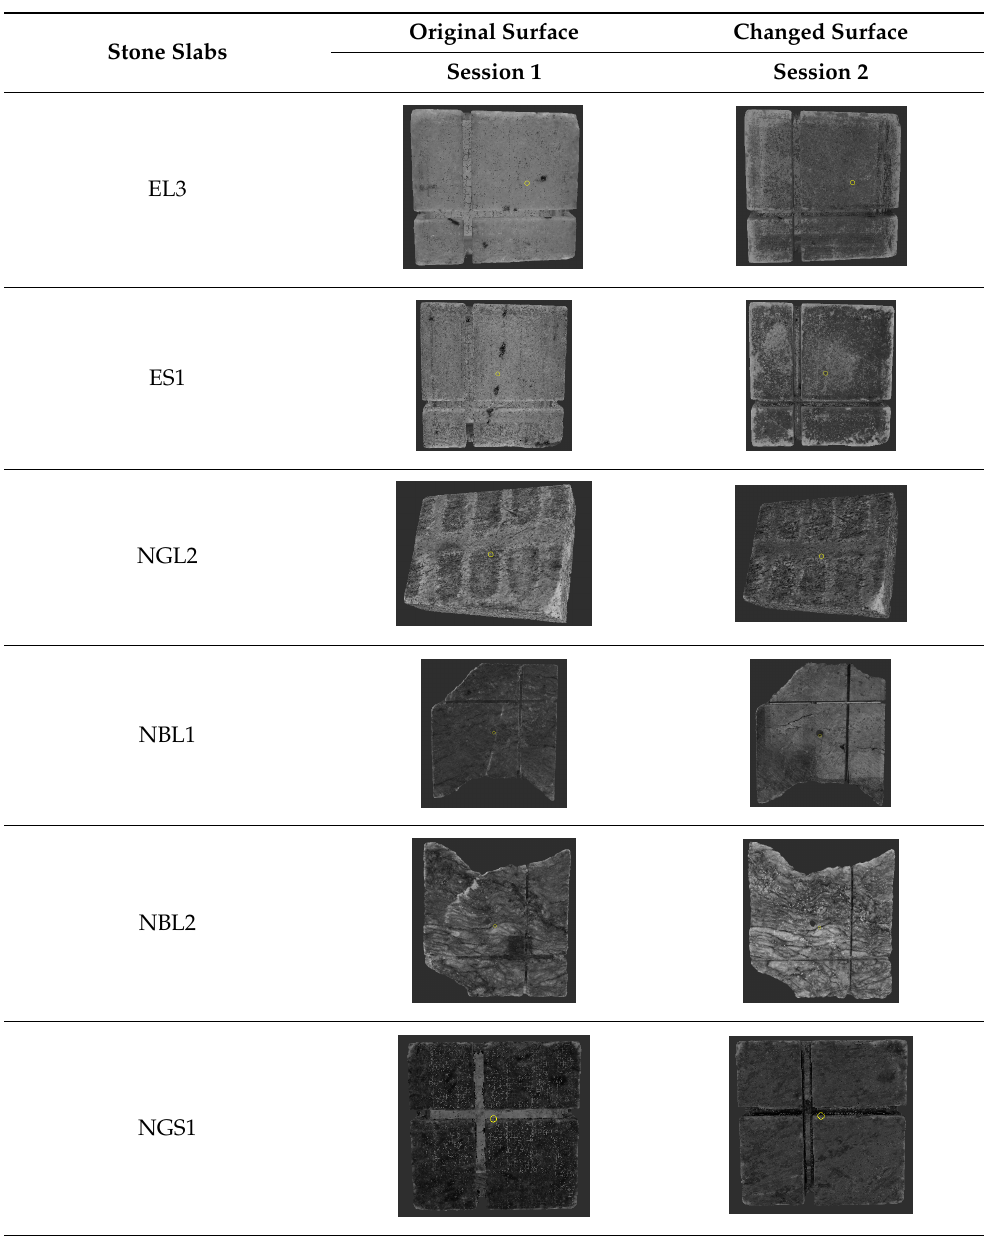
Table 10. Calculated and user input parameters for Case Study